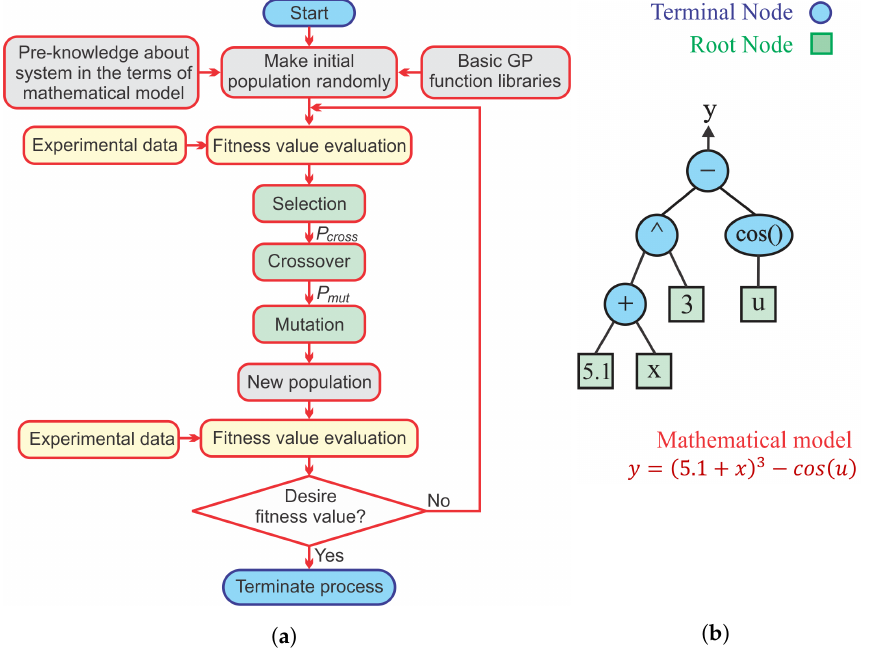
Figure 6. Genetic programming (GP) structure: ( a ) flow chart, ( b ) tree structure